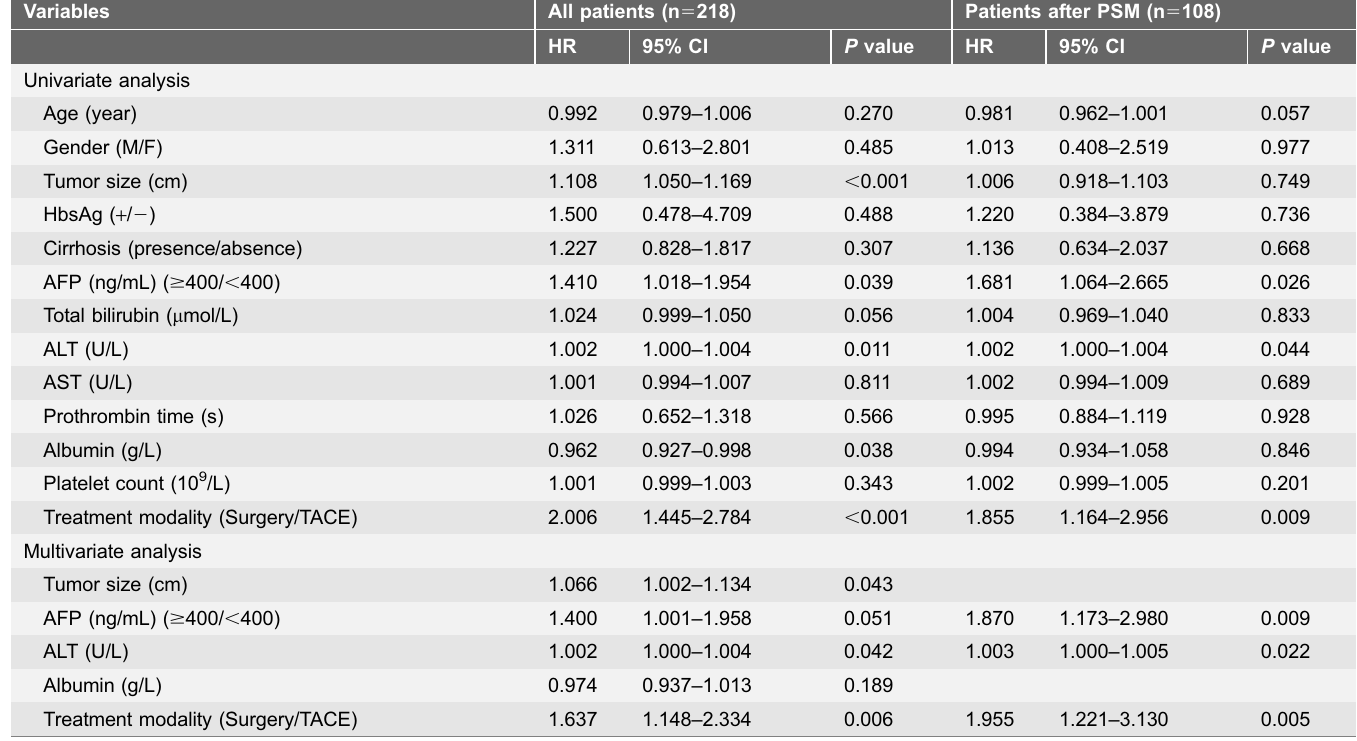
Table 3. Univariate and multivariate analysis to identify factors that predict overall survival in all patients and patients after propensity score matching